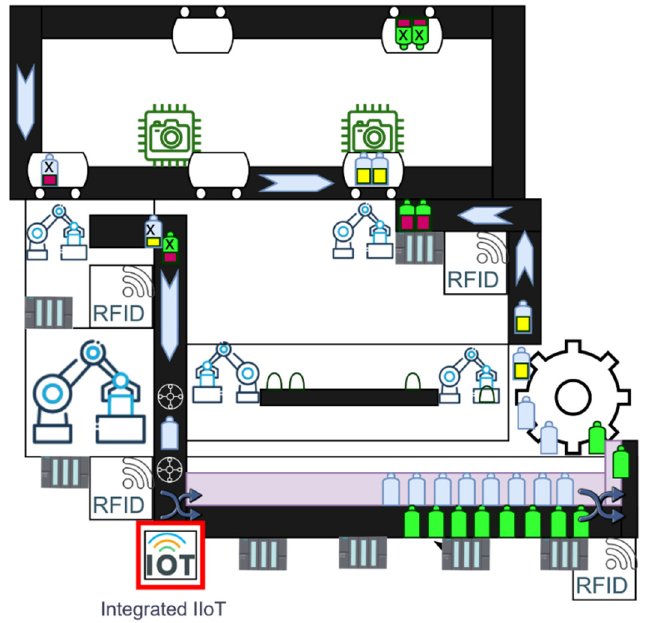
Figure 18. An integrated IIoT device in the production process with a bottle detection function.